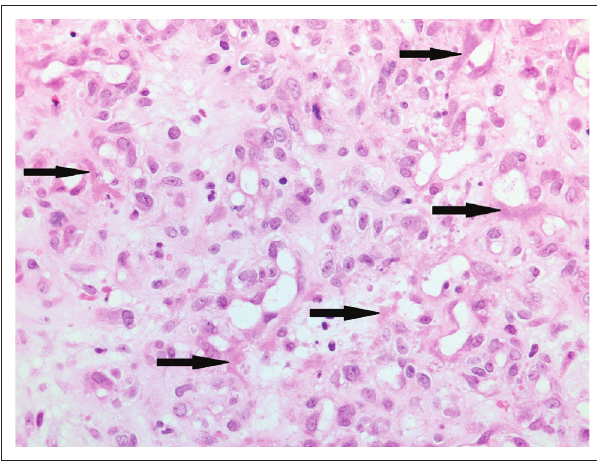
FIGURE 4: A proliferation of capillaries is noted with basophilic clumps of bacteria, indicated by arrows, characteristic of bacillary angiomatosis (original magnification ×